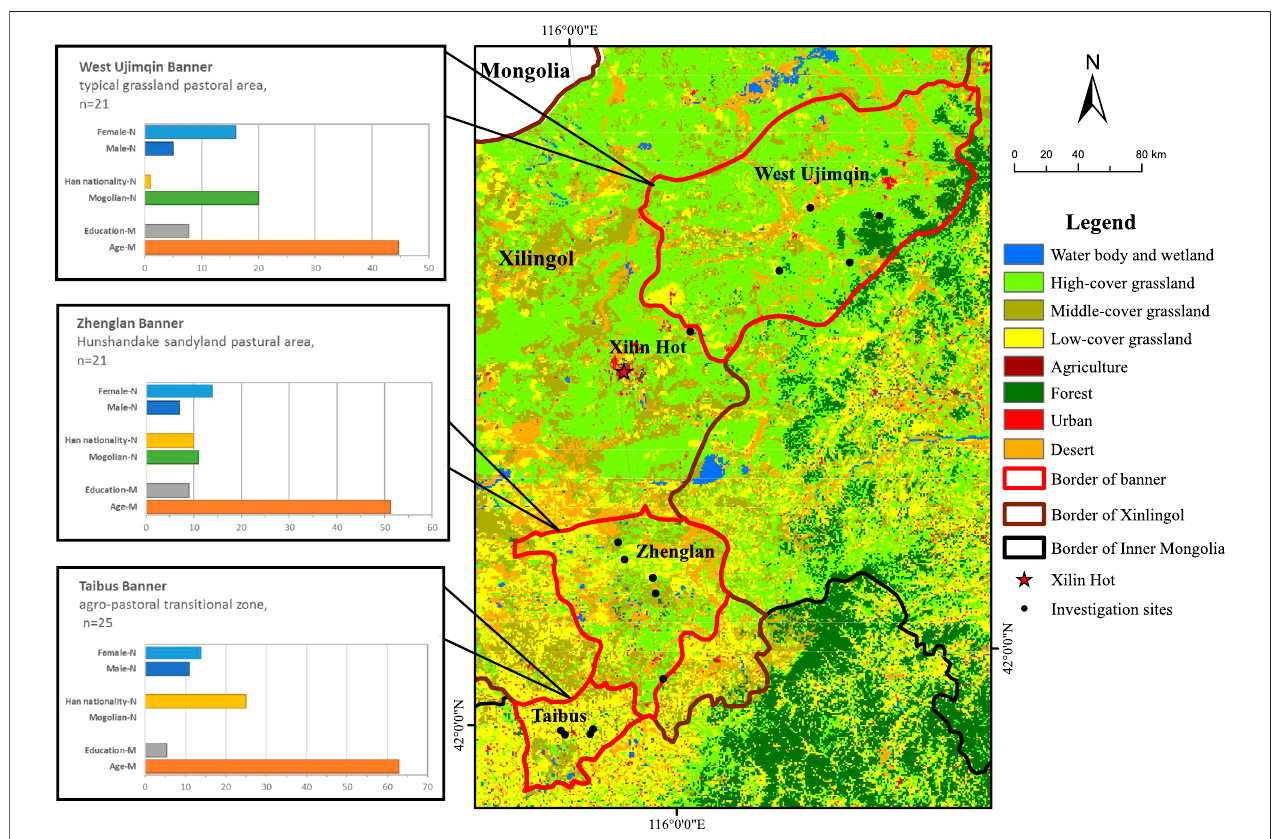
FIGURE 2 | Sociodemographic characteristics of respondents in the three typical study areas. Data source: The data center for Resource and Environment Data PlatformofCAS(http://www.resdc.cn),GlobalPositioningSystem(GPS)locationsofhouseholdquestionnairesurveys,andresultsfromour2019 fi eldsurvey.Notes:N, number of the variable; M, mean of the variable.